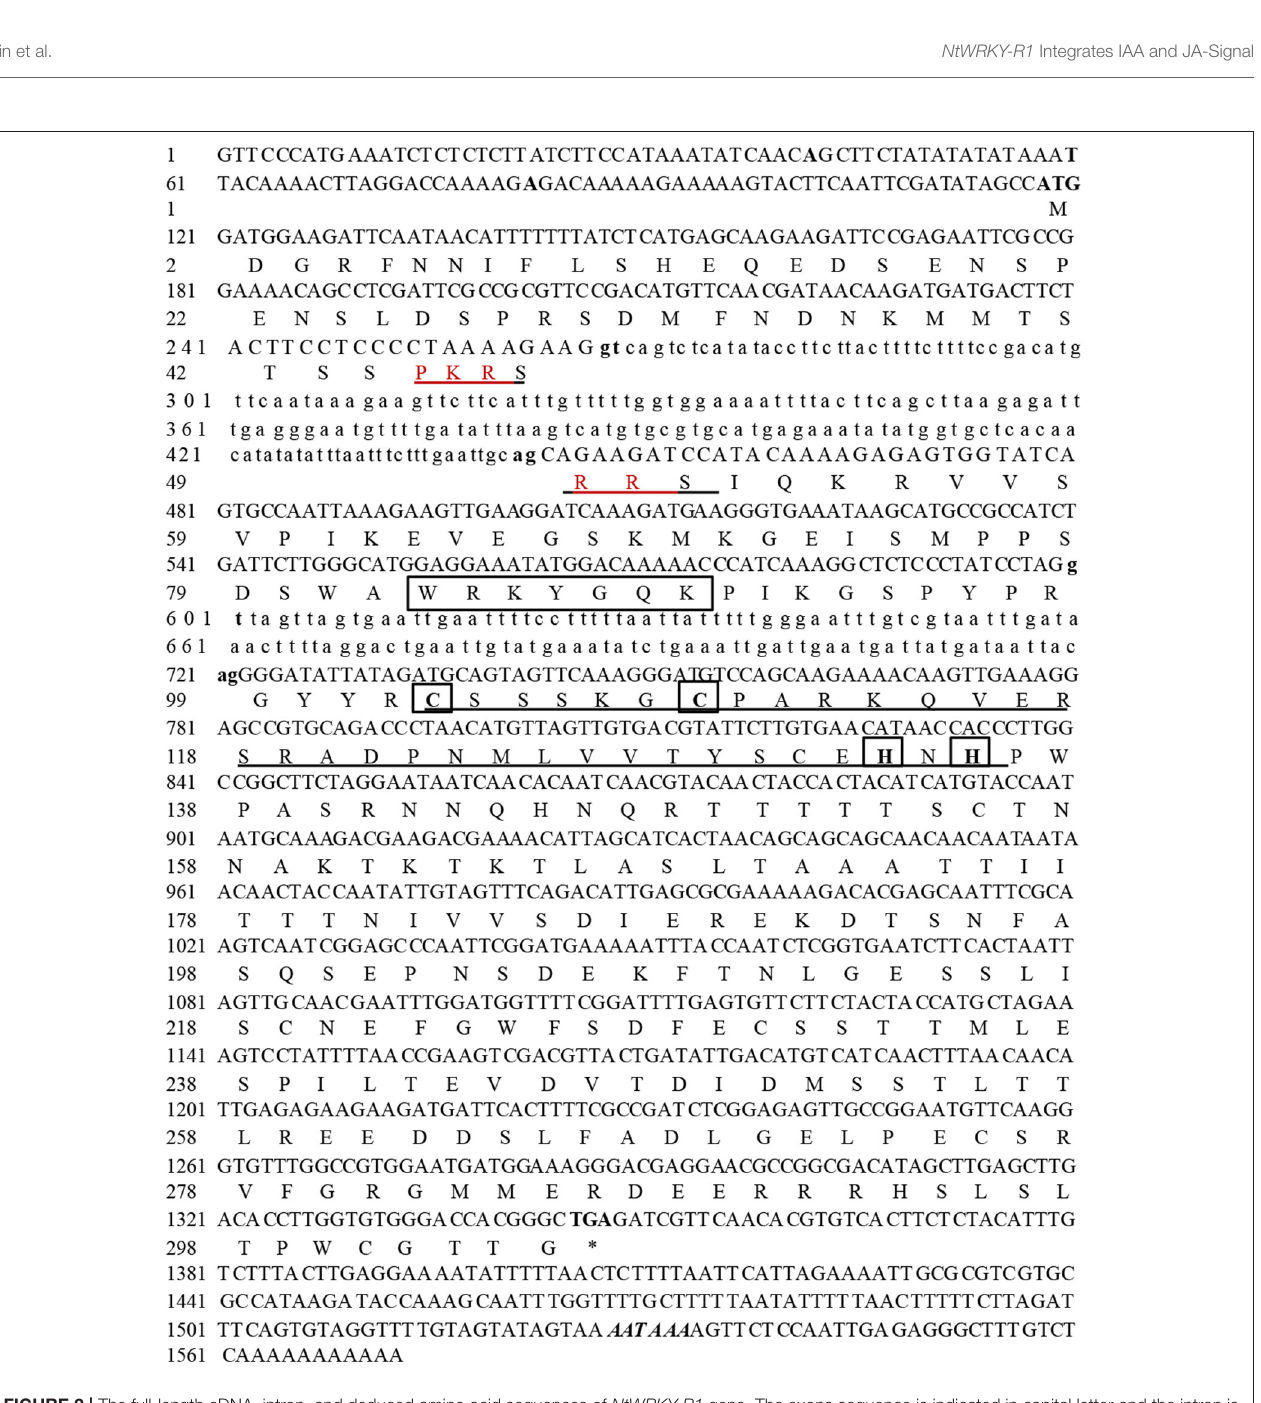
FIGURE 2 | The full-length cDNA, intron, and deduced amino acid sequences of NtWRKY-R1 gene. The exons sequence is indicated in capital letter and the intron is indicated in lowercase. The start codon (ATG), the stop codon (TAG), and a putative exon-intron splicing sites (gt/ag) are shown by bold letters. The putative nuclear localization signal is underlined. The WRKY domain and zinc finger motif (CX5CX23HX1H) are marked by square